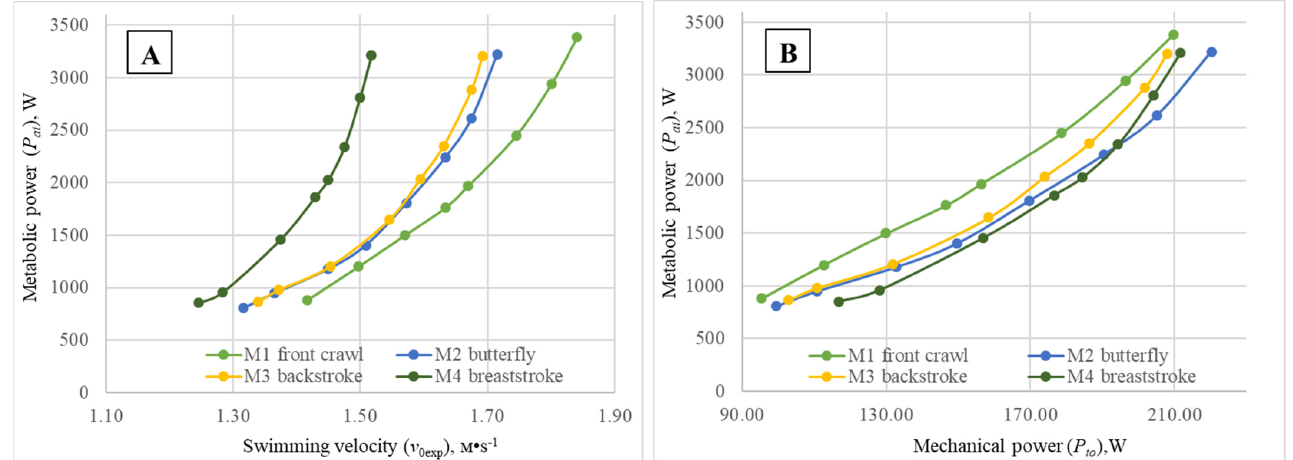
Figure 2. Functional relationships between v 0exp and P ai ( A ), and between P to and P ai ( B ) in the swimming pool 8 × 100 m step-test for male swimmers in the four swimming techniques. Legend: M1 (24 years old, height—1.89 m, body mass— 78.9 kg, V’O 2 res —0.28 l•min-1, C x (ad) —0.365); M2 (23 years old, height—1.84 m, body mass—76.0 kg, V’O2res—0.27 l•min-1, C x( ad ) —0.486); M3 (21 years old, height—1.86 m, body mass—73.0 kg, V’O 2 res —0.26 l•min-1, Cx (ad) —0.491); M4 (23 years